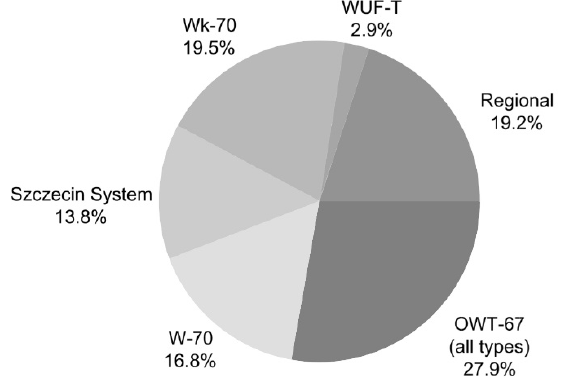
Figure 2. Percentage share of each prefabrication system in the usable area of panel buildings in period 1970–1985 in Poland. Source: drawing by the author based on